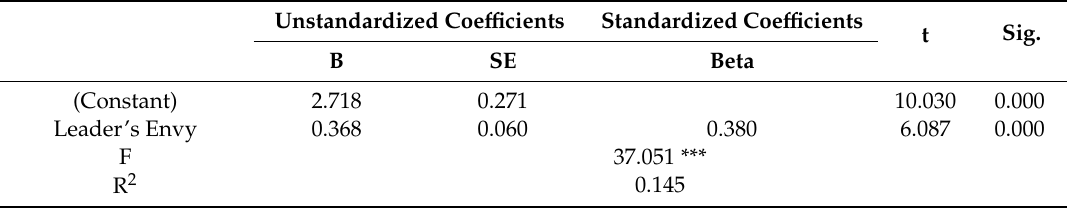
Table 7. Results for the e ff ect of leader’s envy on leadership ostracism